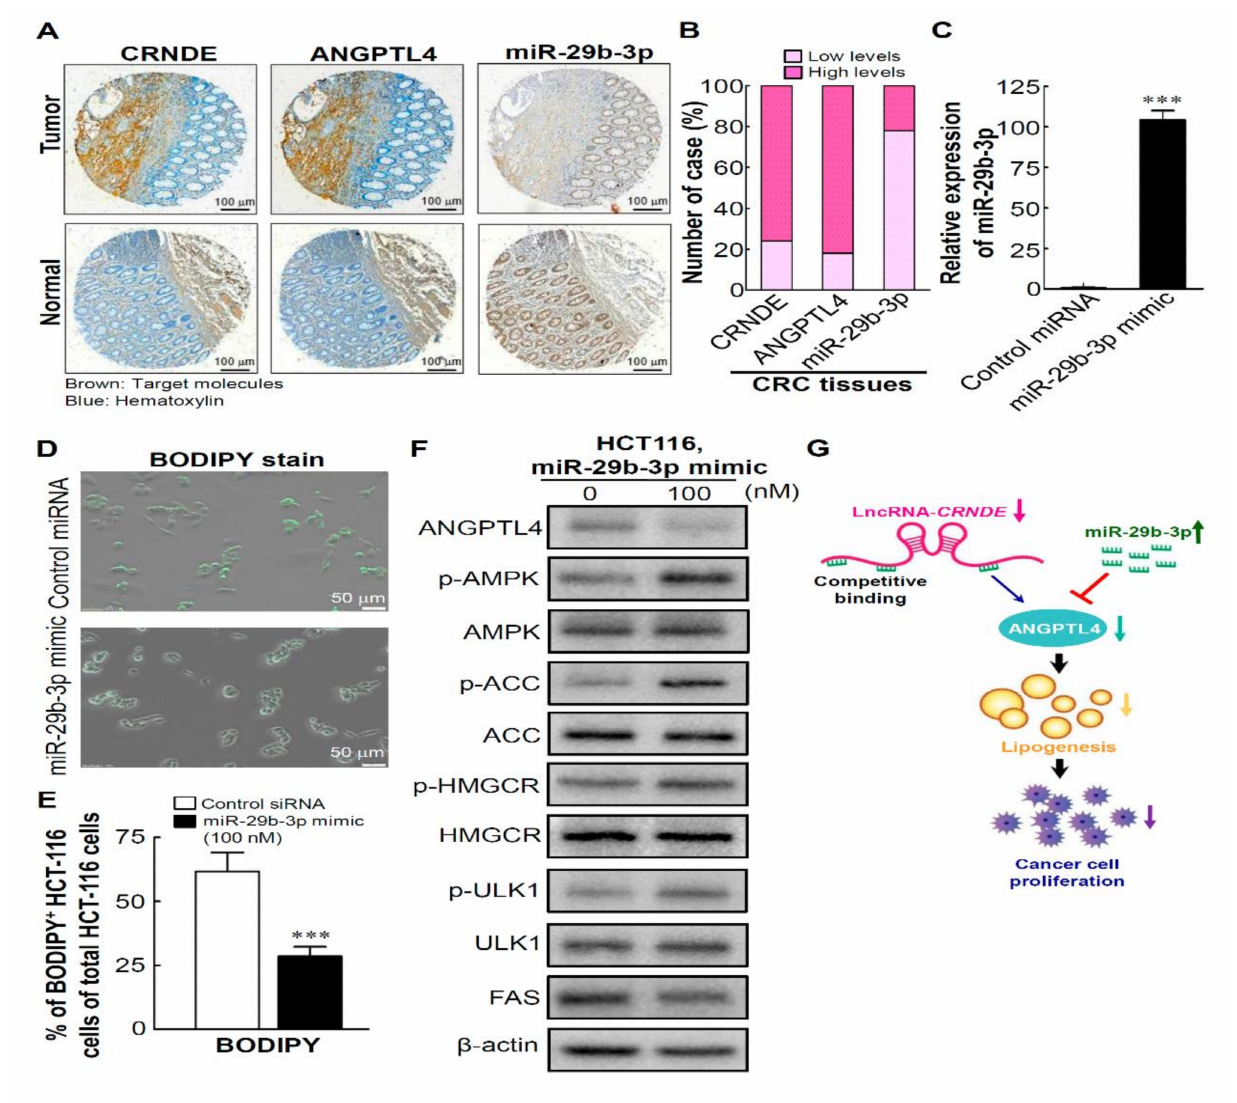
Figure 7. High levels of colorectal neoplasia differentially expressed (CRNDE) and angiopoietin-like 4 (ANGPTL4) and a low level of miR-29b-3p in colorectal cancer (CRC) tissues involved in regulating lipid metabolism. ( A ) Levels of CRNDE, miR-29b-3p, and ANGPTL4 in CRC tissues were examined by IHC and ISH. ( B ) Percentage of cases are plotted on the y-axis, and the type of molecule is plotted on the x-axis. ( C ) Validation of miR-29b-3p expression levels after transfection with a miR-29b-3p mimic for 48 h in the HCT-116 cell line. ( D ) HCT-116 cells were transfected with a miR-29b-3p mimic for 48 h. Images of BODIPY 505/515 -stained cells were captured with a fluorescence microscope. ( E ) BODIPY 505/515 -stained results were quantified and are presented as multiples of change, considering the control miRNA cell value as 1-fold. Error bars represent the mean ± standard deviation (SD). ( F ) Western blot analysis of the effects of miR-29b-3p overexpression on the phosphorylation and expression levels of lipid metabolism-associated targets in HCT-116 cells. ( G ) Schematic model showing that CRNDE silencing induced autophagy of CRC cells by the miR-29b-3p-regulated inhibition of ANGPTL4, causing the inhibition of de novo lipogenesis. *** p <